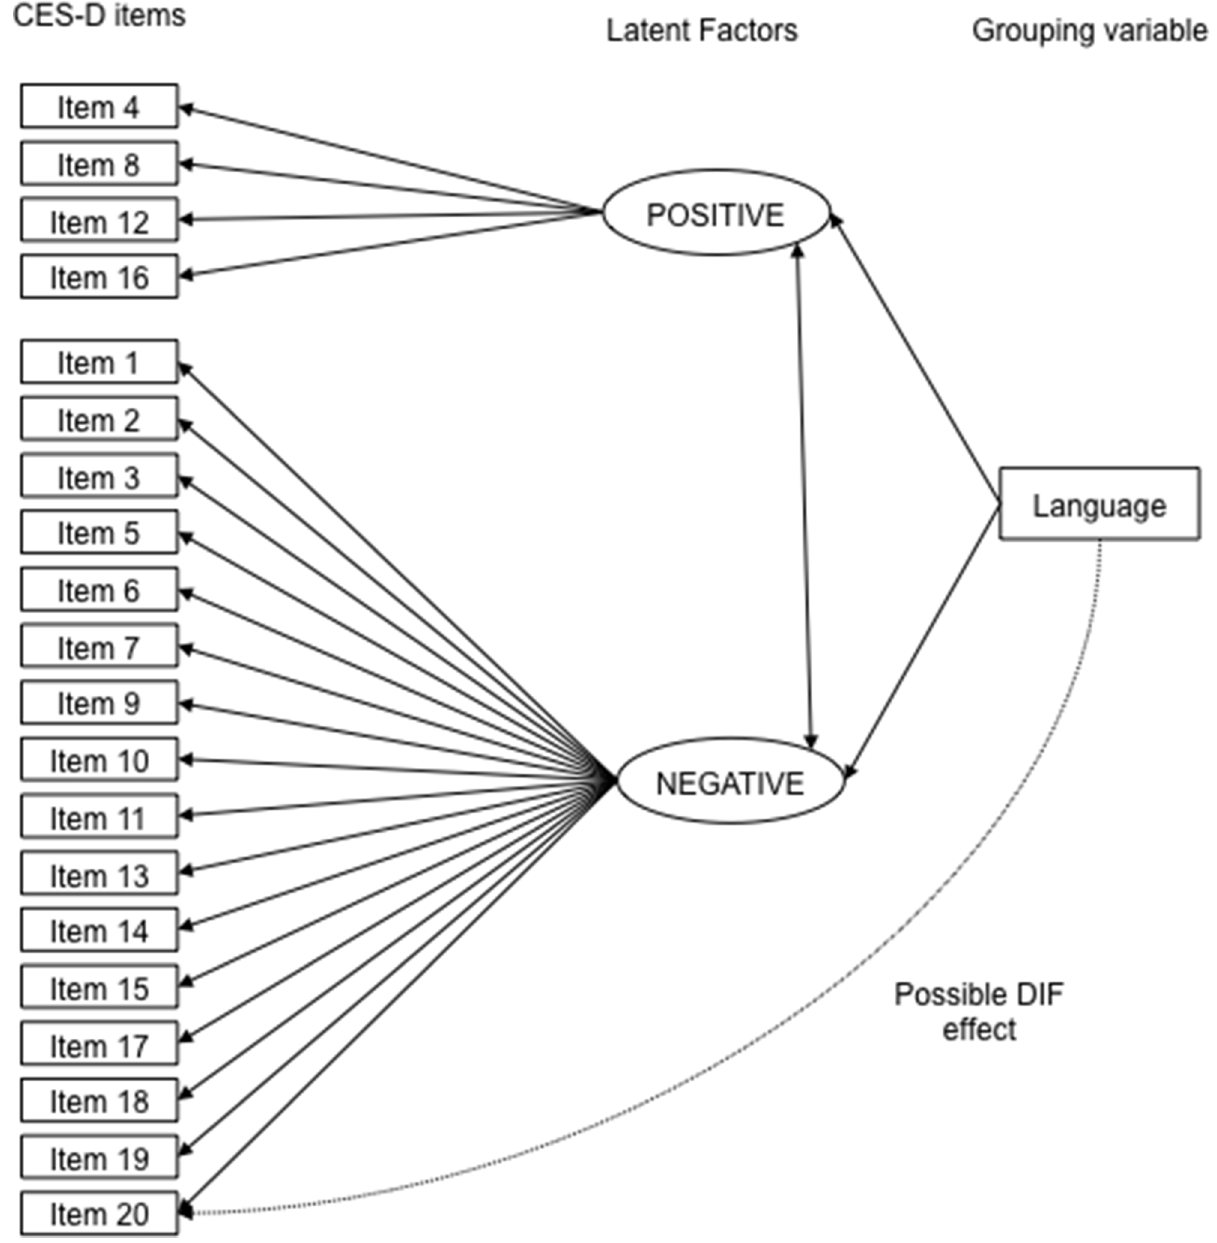
Figure 1. MIMIC Model of the CES-D.